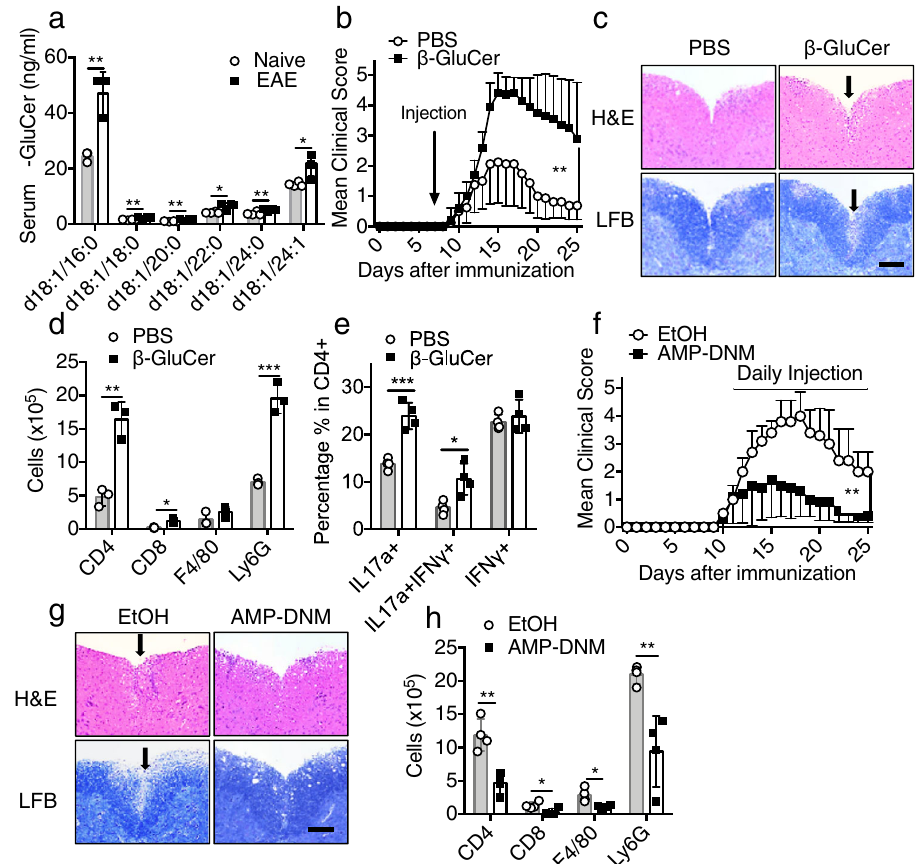
Fig. 6 β -Glucosylceramide administration promotes EAE. a Quanti fi cation of β -glucosylceramide derivatives obtained from the serum of naive and EAE mice at the peak of the disease, n = 4 biological replicates. b EAE clinical scores of wild-type mice treated with synthetic β -glucosylceramide (150 μ g/mice) or vehicle (PBS) on day 10 after EAE induction, n = 5 mice. c Hematoxylin and eosin (H&E) staining (upper panels) and Luxol fast blue staining (lower panels) of lumbar spinal cords EAE mice harvested at the peak of disease. Scale bar, 100 μ m. Arrows in the upper panel indicate in fl ammatory cells in fi ltration, and arrows in the lower panel indicate demyelination area. Representative data are shown for n = 4. d Absolute numbers of CNS-in fi ltrating cells were measured at the peak of disease by fl ow cytometry with indicated antibodies, n = 3 biological replicates. e Flow cytometry analysis of CD4 + lymphocytes from the brain of EAE mice at the peak of the disease, n = 4 biological replicates. f EAE clinical score of wild-type mice treated with AMP- DNM (25 mg/kg) or vehicle (EtOH) since the start of EAE symptom, n = 5 mice. g Hematoxylin and eosin (H&E) staining (upper panels) and Luxol fast blue staining (lower panels) of lumbar spinal cords from EAE mice harvested at the peak of disease. Scale bar, 100 μ m. Arrows in the upper panel indicate in fl ammatory cells in fi ltration, and arrows in the lower panel indicate demyelination area. Representative data are shown for n = 4. h Absolute numbers of CNS-in fi ltrating cells were measured at the peak of disease by fl ow cytometry with the indicated antibodies, n = 4 biological replicates. * P < 0.05, ** P < 0.01 (Two-sided student ’ s t test for a , d , e , h ). ** P < 0.01 (two-way ANOVA, b , d ). Data are represented as mean ± SD. Exact P values for asterisks (from left to right): a 0.0016 0.0061 0.0178 0.0103 0.0129 b < 0.0001 d 0.0024 0.0144 0.0007 e 0.00056 0.01513 f 0.0033 h 0.0023 0.0323 0.0177 0.0057.